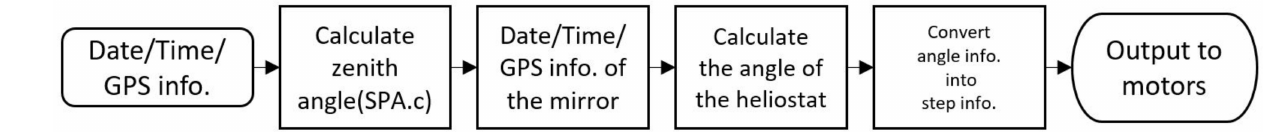
Figure 11. Flow chart of the sun-tracking algorithm of the heliostat